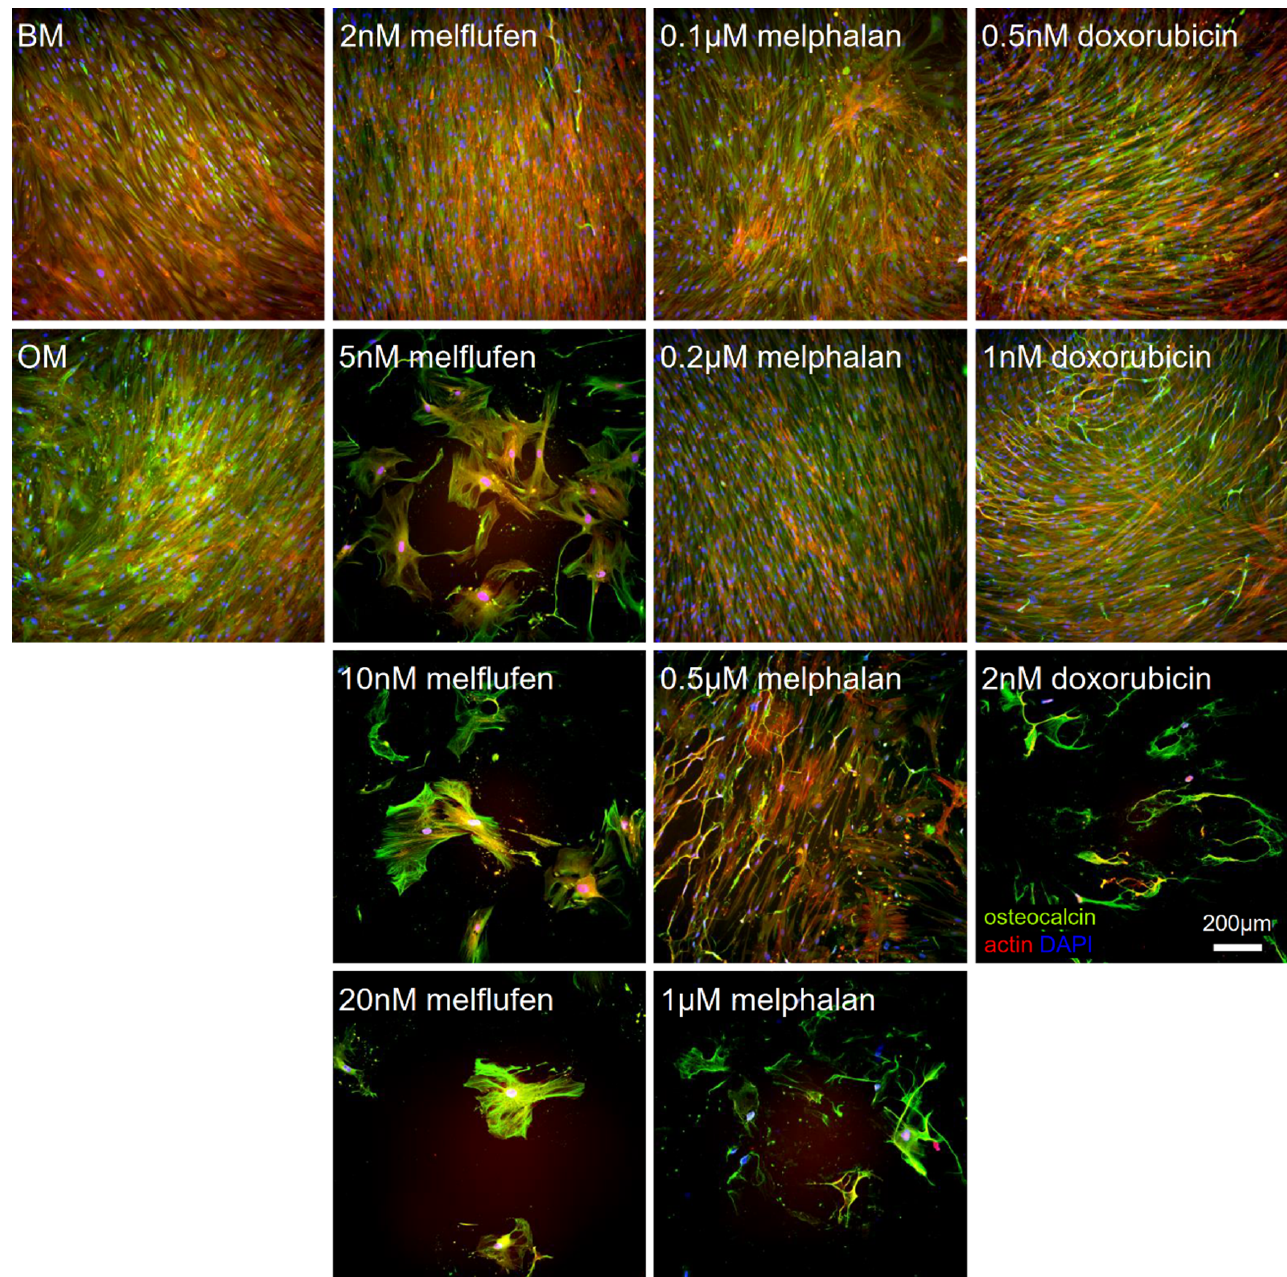
Figure 12. Drug effect on expression of osteocalcin in osteogenically differentiated BMSCs. Immunofluorescent staining for osteocalcin (green) in osteogenically differentiated BMSCs at 21 days of culture with melflufen, melphalan, and doxorubicin added at indicated concentrations. Counterstained with phalloidin for actin filaments (red) and DAPI for nuclei (blue). BM, basic medium control; OM, osteogenic medium control without drugs. Scale bar: 200 µm.